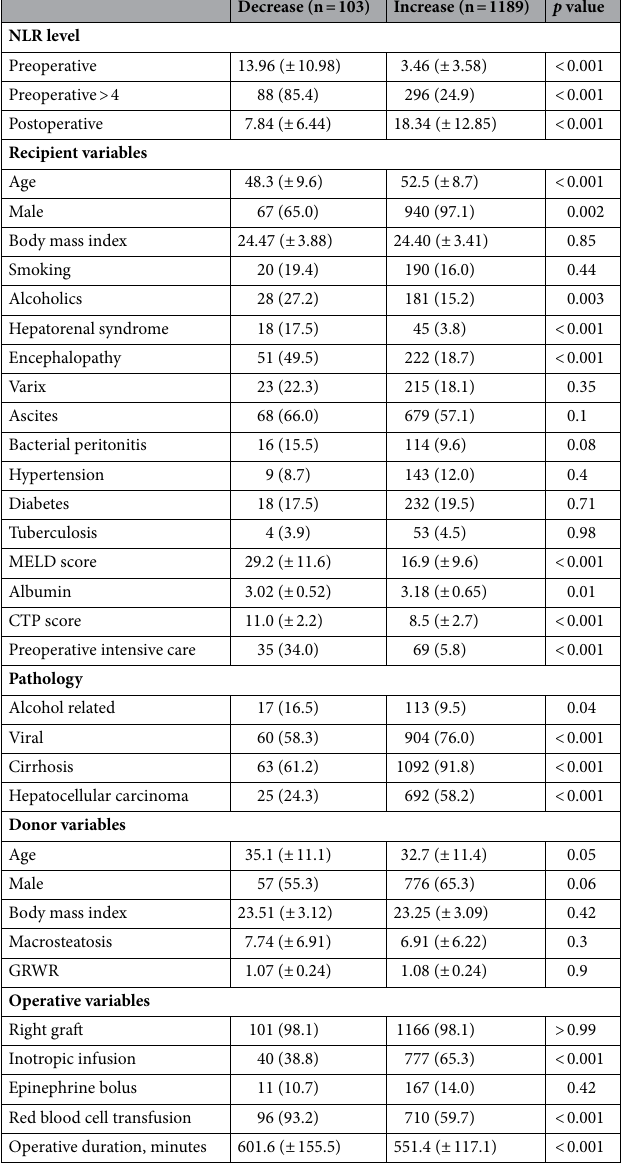
Table 1. Baseline characteristics of the entire population according to the change of NLR. Values are n (%) or mean (± SD). NLR neutrophil-to-lymphocyte ratio, MELD model for end-stage liver disease, CTP Child–Pugh score, GRWR graft to recipient-body weight